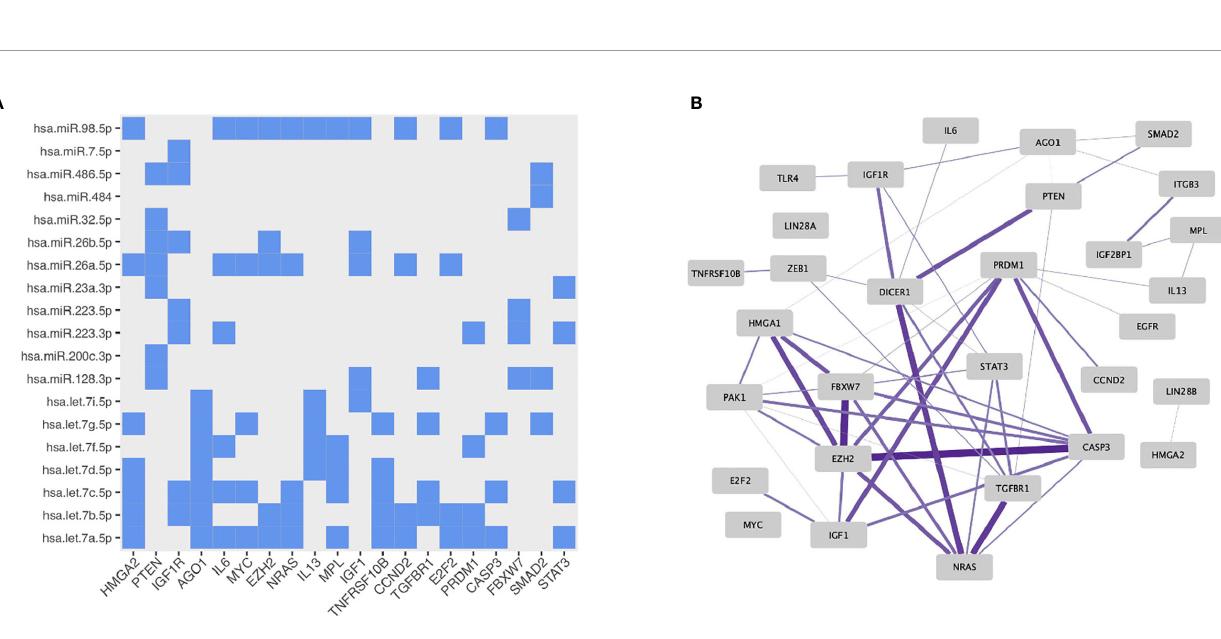
FIGURE 5 | Properties of the miRNA-target enrichment analysis based on the differentially expressed miRNAs identi fi ed from comparing MTX treated RA patients to healthy controls: (A) Enriched miRNA-target interactions. The x-axis shows the speci fi c enriched target gene and the y-axis the speci fi c targeting miRNA. (B) Gene expression correlation network in mature B cells generated using the Immuno-Navigator database. Target genes with correlated expressions are connected by an edge. The thicker and more saturated the line, the stronger the